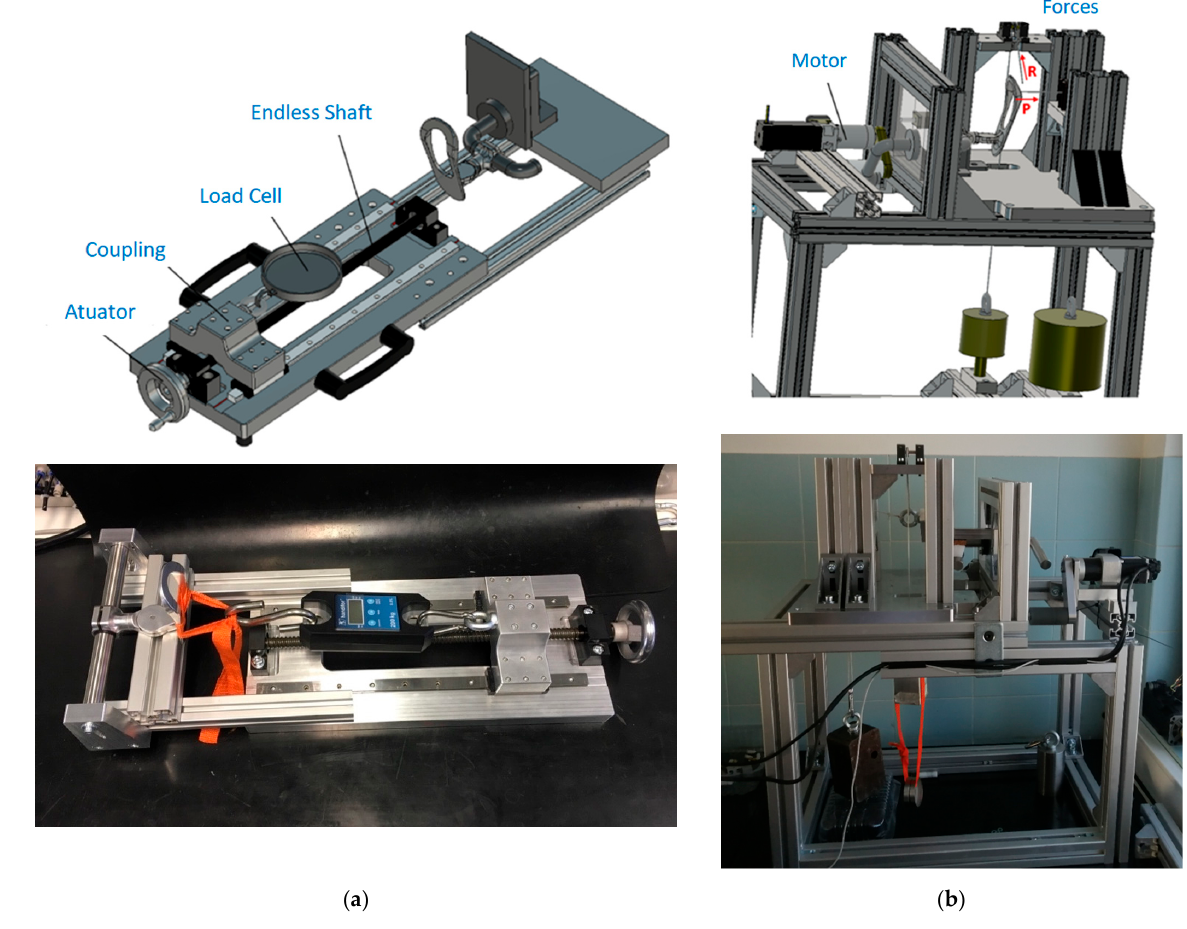
Figure 12. Equipment developed for experimental tests: ( a ) uniaxial traction; ( b ) durability.